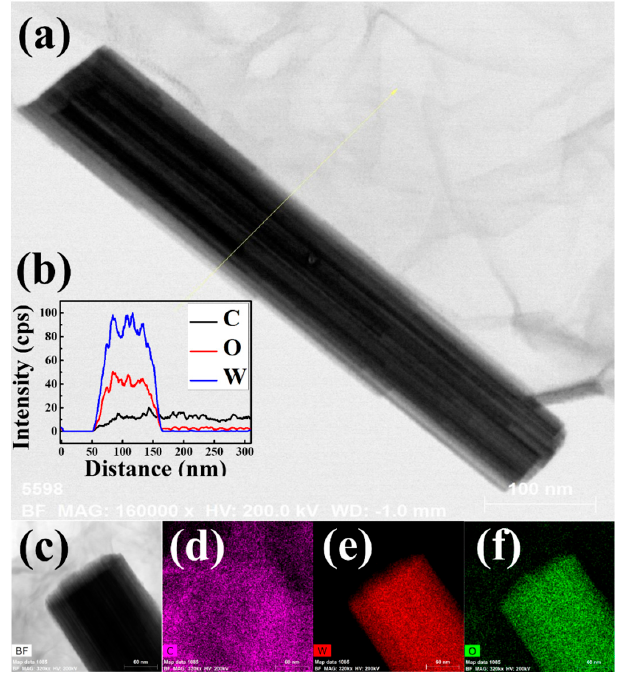
Figure 4. ( a ) Bright-field TEM images of WO 3 /GR-0.1 (the yellow area indicates the line-diffusion analysis position); and ( b ) EDS curves showing C, O and W elements in the direction of the arrow indicated in ( a ); ( c ) Bright-field TEM image of a select area; and ( d – f ) EDS element mapping images of C, O and W.